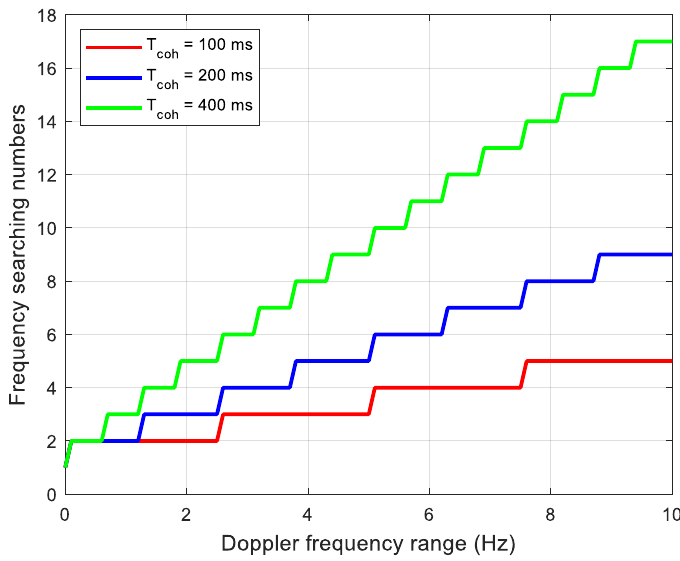
Figure 10. Frequency searching numbers according to the frequency range.